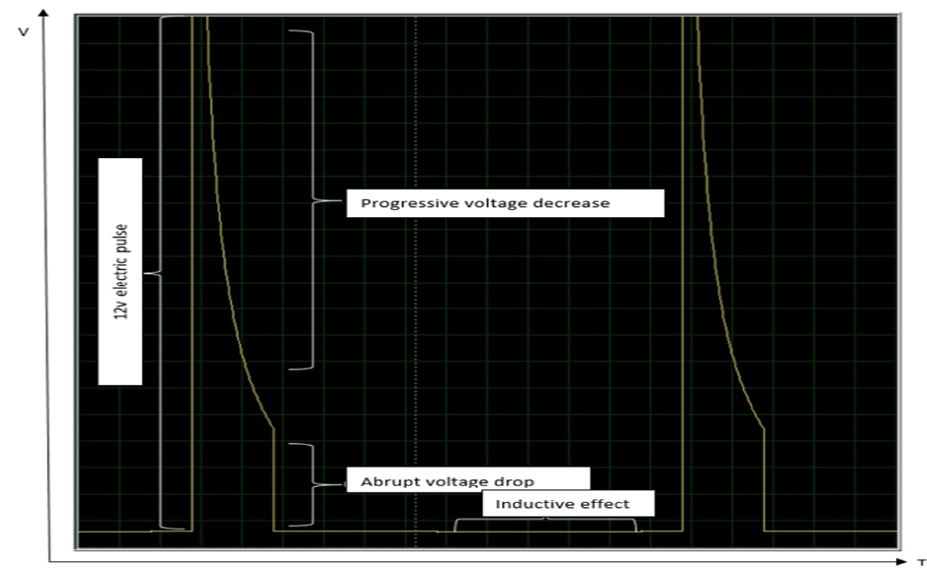
Figure 8. Behavior of the electric pulses sent to the motor.